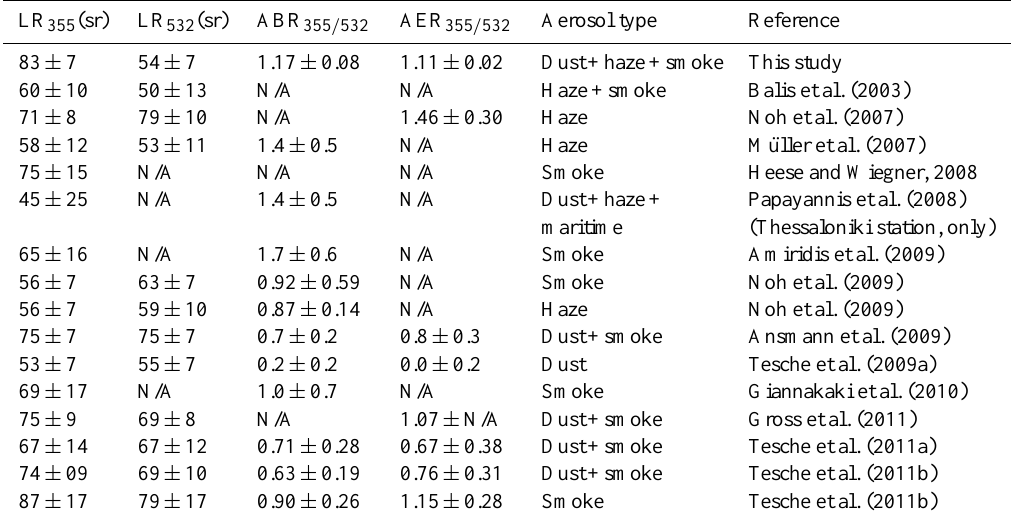
Table 1. Raman lidar-derived mean aerosol optical properties (LR 355 , LR 532 , ABR 355 / 532 , AER 355 / 532 ) obtained from different campaigns or systematic measurements).